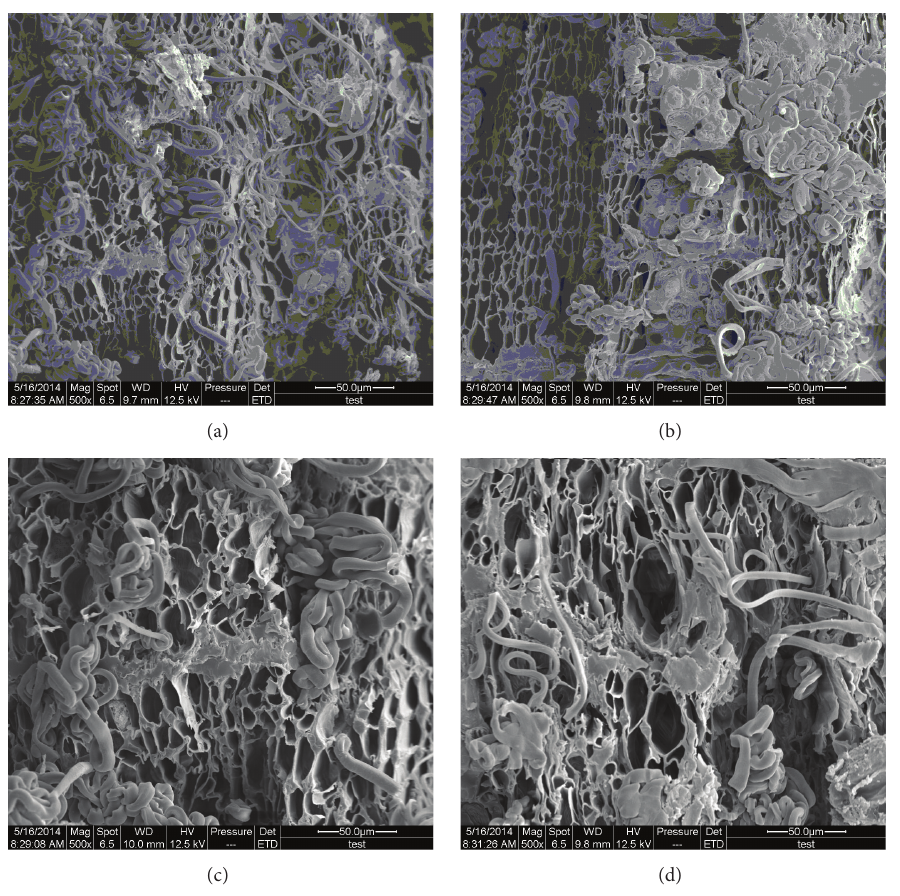
Figure 5: The SEM micrographs of raw material (a), degreased material (b), microwave-assisted water treatment material (c), and IMSHE treatment (d).